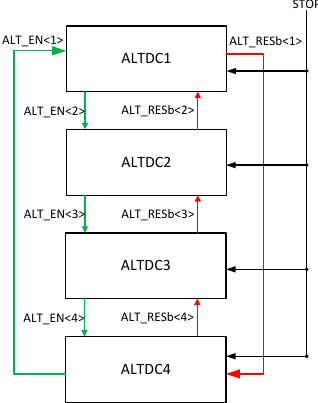
Figure 4. ALTDC daisy chain block diagram.